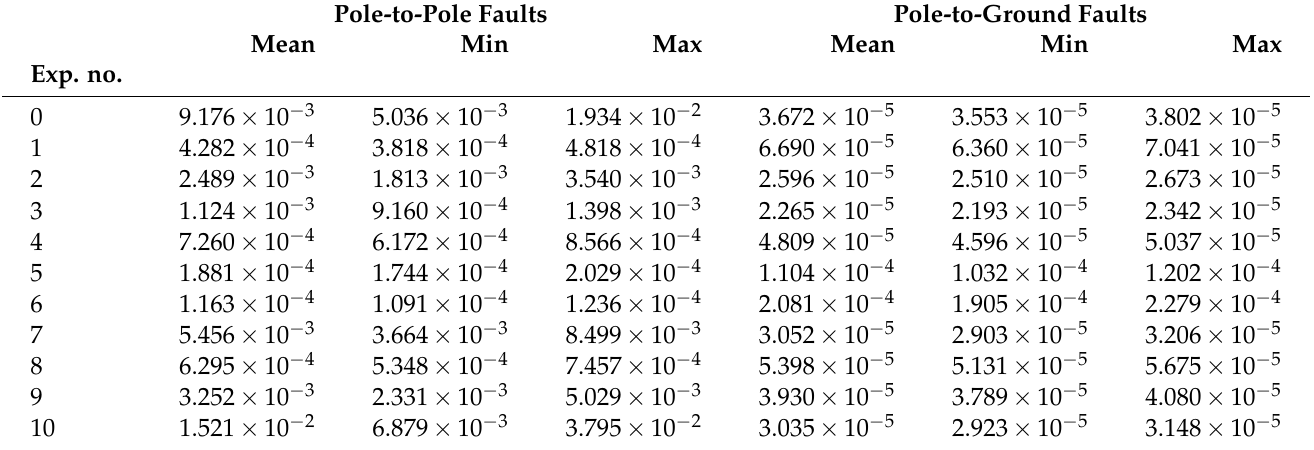
Figure 10. Application of the algorithm to two voltage samples, one of pole-to-pole and one of pole-to-ground faults. ( a ) Bayesian model has efficiently captured the shape of measurements. ( b ) Distribution of data depth shows good discrimination of pole-to-ground from the reference depth. Isolated pole-to-pole fault is also shallower than reference but reasonably close. It suggests that voltage is a much better diagnostic indicator in this case. Table 4. When analyzing voltage signal in the context of reference depth of pole-to-pole fault (with mean of 6.223 × 10 − 2 and spreading from 2.108 × 10 − 2 to 2.135 × 10 − 1 ) we can see that it is a much better indicator than current. Pole-to-ground scenarios are being clearly discriminated as ‘shallow’ with depths at the level of 10 − 5 as in the previous case. The pole-to-pole current signals are also separated from the reference but their depths are even sometimes overlapping reference or are relatively close to